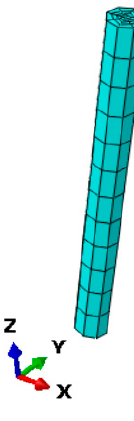
Figure 1. Typical 3D finite-element meshing in ABAQUS.